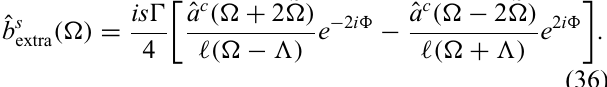
FIG. 3. Spectral mappings for a two-tone- driven oscillator showing the emergence of the extraneous QBA sidebands. Both paths linking the nominal QBA (green dashed arrows) to the nominal output sidebands ˆ a c ((cid:2)) → ˆ b s ((cid:2)) (blue arrows with green filling) via ˆ X have net zero contribution from the phase (cid:12) , in contrast to the extra- neous QBA components (yellow dashed arrows) that are mixed into the nominal out- ˆ put ˆ a c ((cid:2) ± 2 ˜ (cid:2)) → b s ((cid:2)) (blue arrows with yellow filling) with a net phase contribution of e ∓ 2 i (cid:12) . The extraneous output components ˆ b s ((cid:2) ± 2 ˜ (cid:2)) (black arrows with filling) can be filtered out in postprocessing (indicated by black